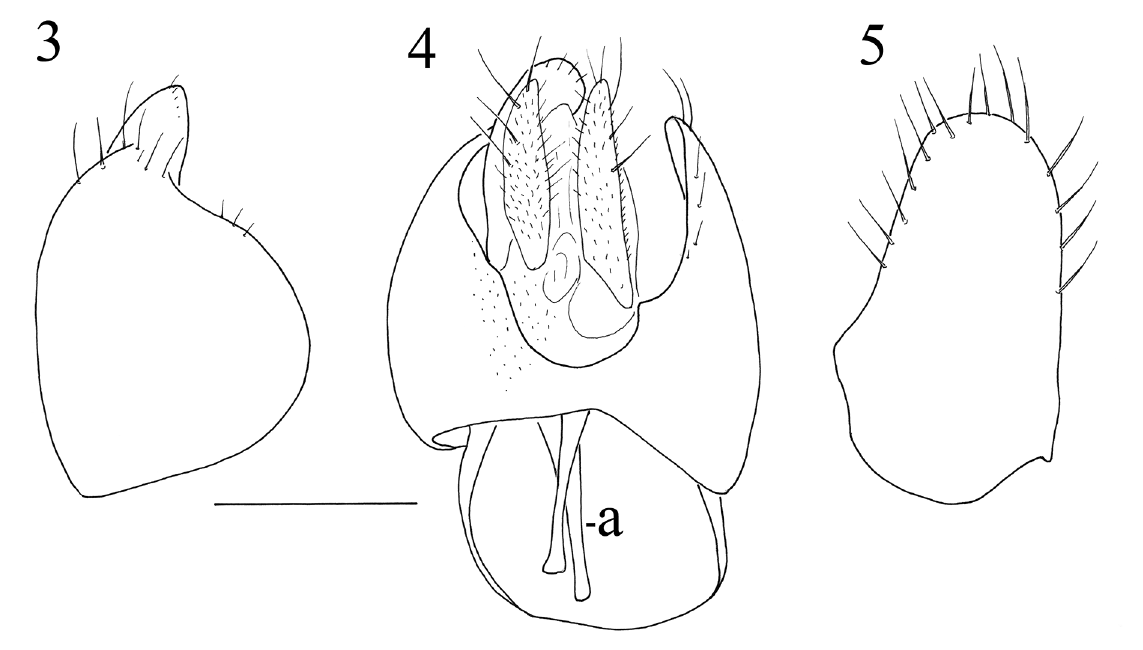
dorsal view. 5 . Left epandrial lamella. Scale bar = 0.1